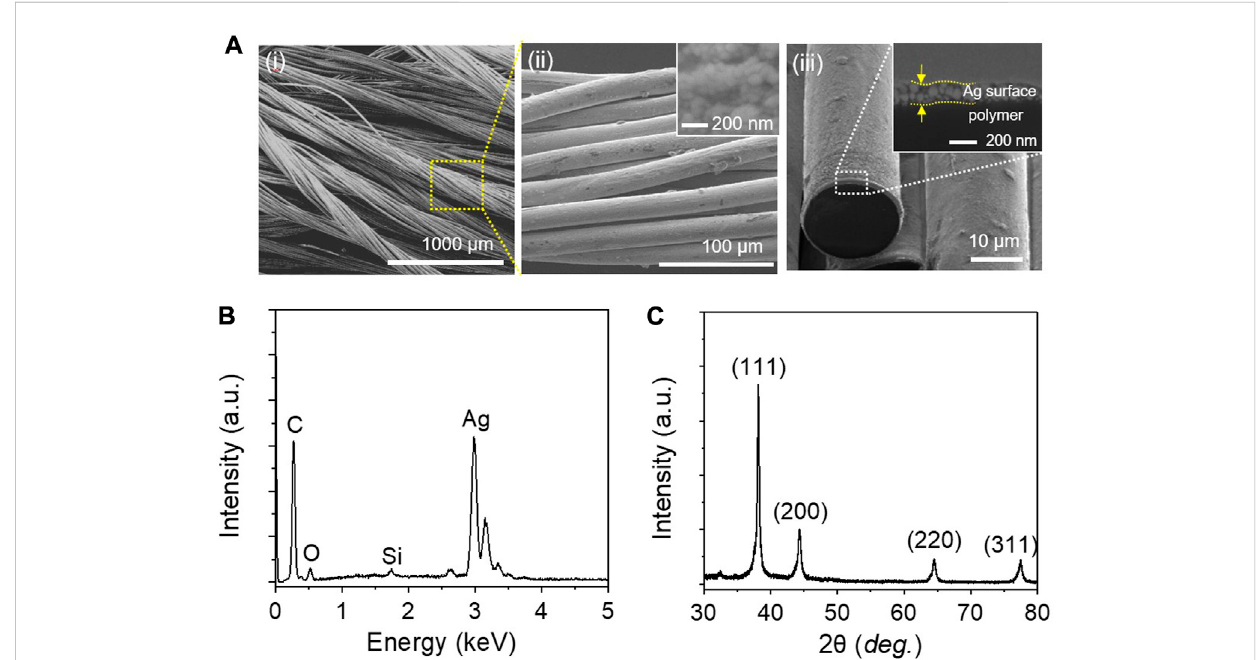
FIGURE 1 (A) TypicalSEMimagesofSCCY:(i)multi fi lamentyarn,(ii)single fi lament(inset:topviewofthesilversurface),(iii)singlestrand(inset:enlargedcross- sectional SEM image of silver layer marked as the white dashed area, (B) EDS spectra and (C) XRD pattern of